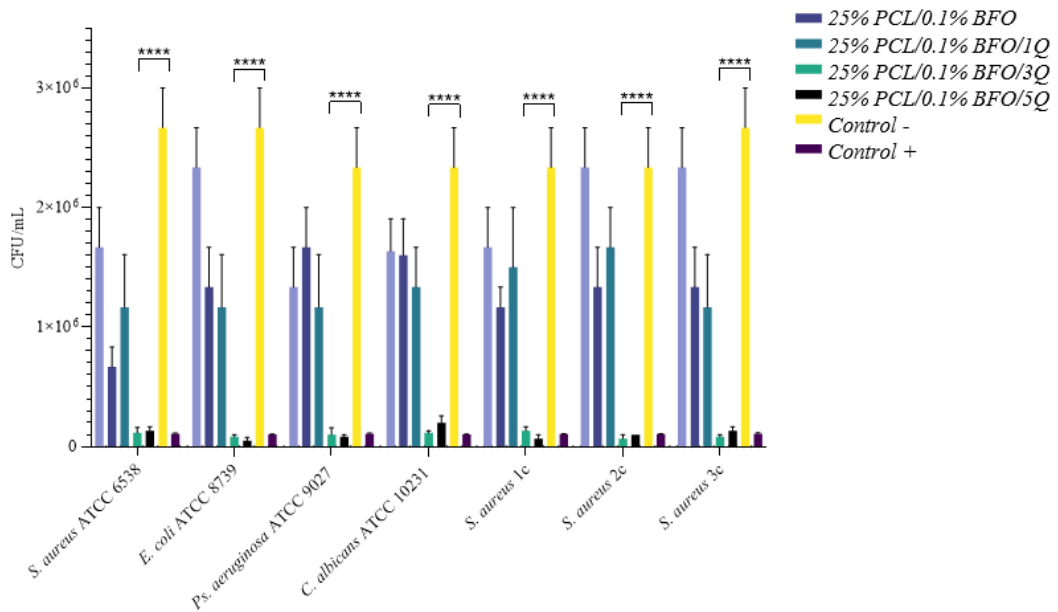
Figure 7. Antimicrobial susceptibility of microfibrous scaffolds, as CFU/mL reduction. Positive con- trol = 5 mg/mL of Q solution. Negative control = untreated bacterial suspensions. **** p value < 0.002.